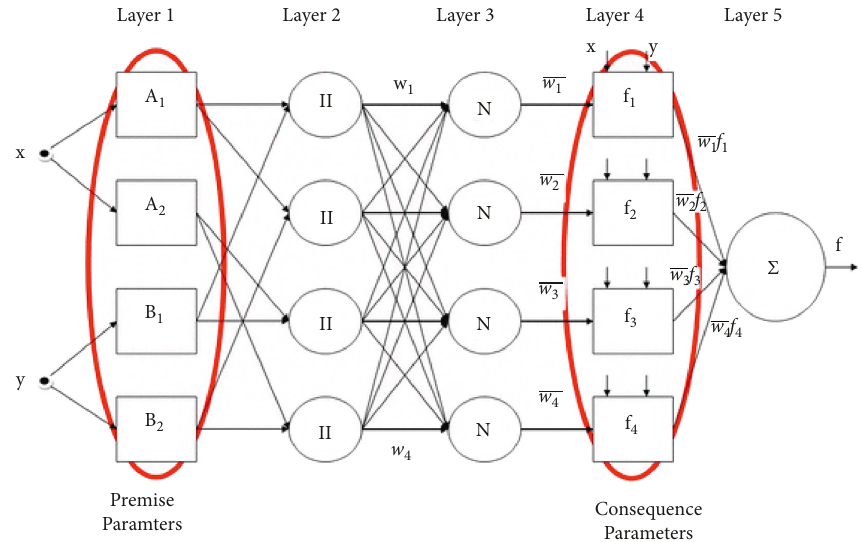
Figure 1: The scheme of the ANFIS algorithm.